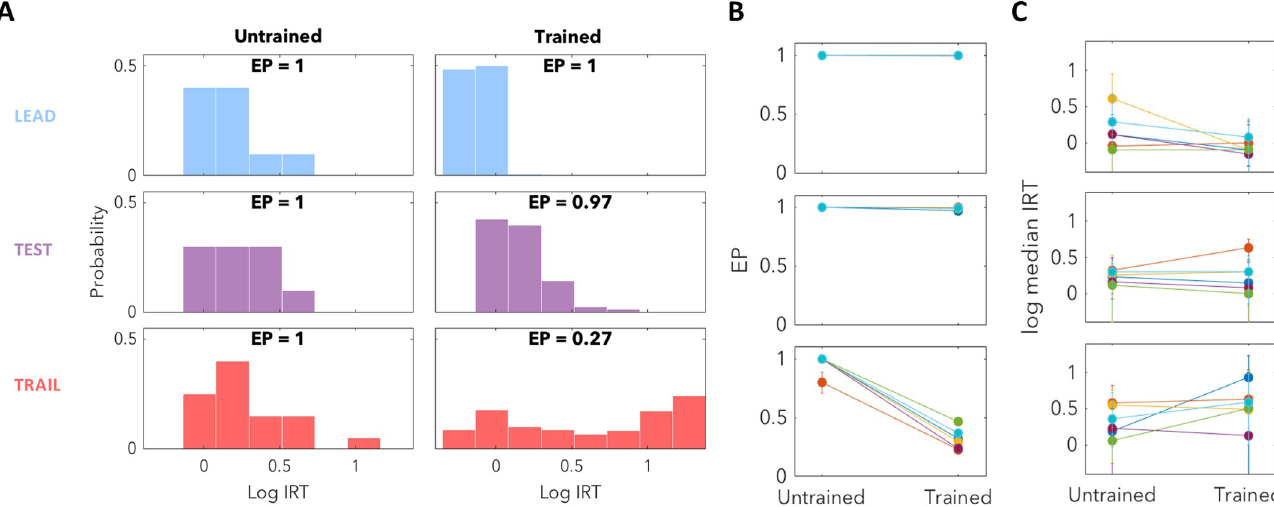
Fig 2. Subjects learn to predict oncoming trials. ( A ) We compare the responses of subject 1 when it has just begun training with the triad structure to its responses once trained. Early in training (left) the subject responds with short IRTs for all three trial types and EPs of 1, reflecting engagement in the task but an inability to predict the oncoming trial type. After training (right), IRTs reflect accurate prediction of oncoming lead and test trials, with certain engagement and rapid but generally distinguishable responses on the two trial types. For negligibly rewarding trail trials, the subject responds appropriately in the majority of cases, as indicated by both a low EP and a number of responses with long IRTs. However, in a minority of cases subjects also responded with short IRTs, which indicates inaccurate prediction of the trail trial. ( B ) For lead and test trials, EPs remained close to 1 (subject 1’s response in dark blue). On trail trials, EPs were found to decrease consistently for all 6 subjects (binomial proportion test; h 3 ). ( C ) For lead trials, median IRTs remained short, and for 4/6 subjects became even shorter once trained (permutation test; h 4 ), as subjects learned to predict the highly rewarding lead trial. For test trials, with their lower expected rewards, median IRTs remained relatively constant and were longer in trained subjects than lead trial IRTs for all subjects (permutation test; h 2 ). For the poorly rewarding trail trials, median IRTs appeared not to change consistently, but we examine the properties of the trail trial distribution in more detail in Fig 3.